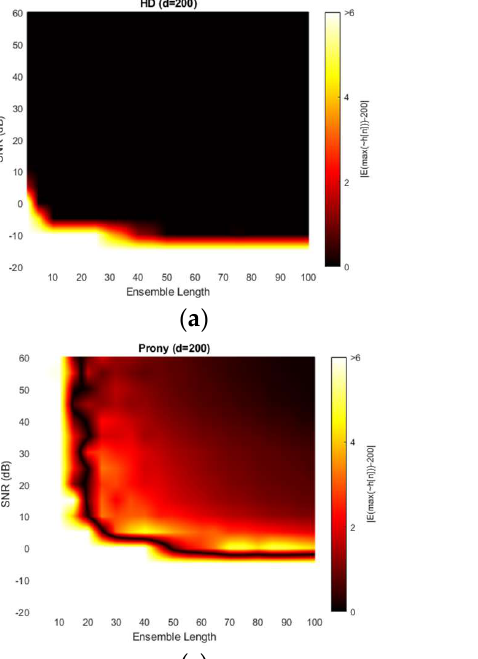
( d ) Figure 16. Variance of estimation with given ensemble average length & SNR for 200-sample delay: ( a ) non-parametric HD; ( b ) Yule-walker HD; ( c ) Prony HD; ( d ) Steiglitz-McBride HD. Figure 16 shows the variance for 200-sample delay with various SNR and ensemble length. Similar to the previous simulation outcomes, all four methods provide the near zero variance for high SNR and long average length. Except the Yule-Walker and Prony method, the variance distribution is almost identical to the near and middle microphone simulation counterpart. The Yule-walker method produces the slightly increased white area. The Prony method illustrates the wider and